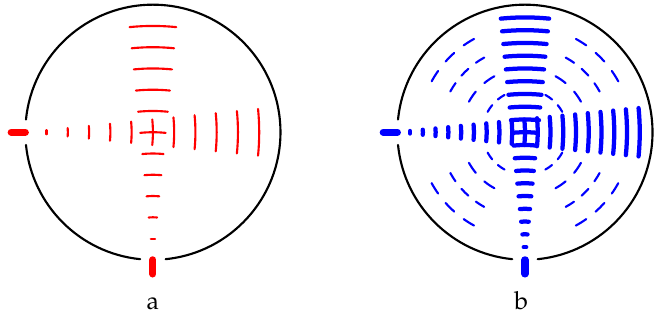
Figure 1. Scattering of low-energy photons: ( a ) not yet seen; ( b )